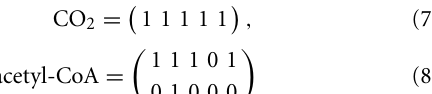
p ij molecules. Thus, each row in the matrices C 4 and C 5